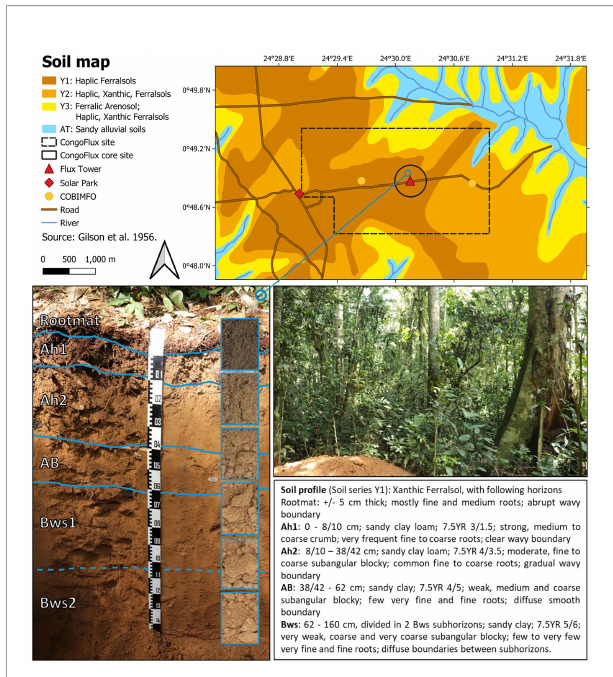
FIGURE 2 | Soil map (top) of the CongoFlux research site and soil pro fi le (bottom) of a Haplic Ferrasol (Y1) near the eddy covariance fl ux tower [0°48 ’ 52.0 ” N 24°30 ’ 08.9 ” E] in Yangambi, Democratic Republic of the Congo. The understory present on the described soil pro fi le is also shown (middle- right). Source soil description: personal communication; Prof. Geert Baert. Soil classi fi cation reference: IUSS Working Group WRB (42). Source for soil map: